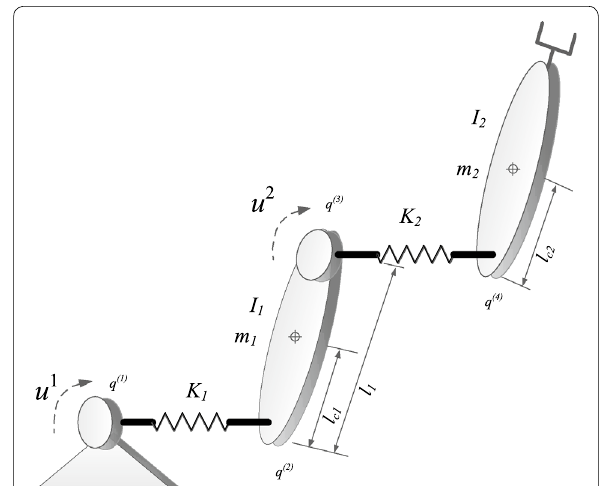
Figure 9 Two‑link flexible joint manipulator